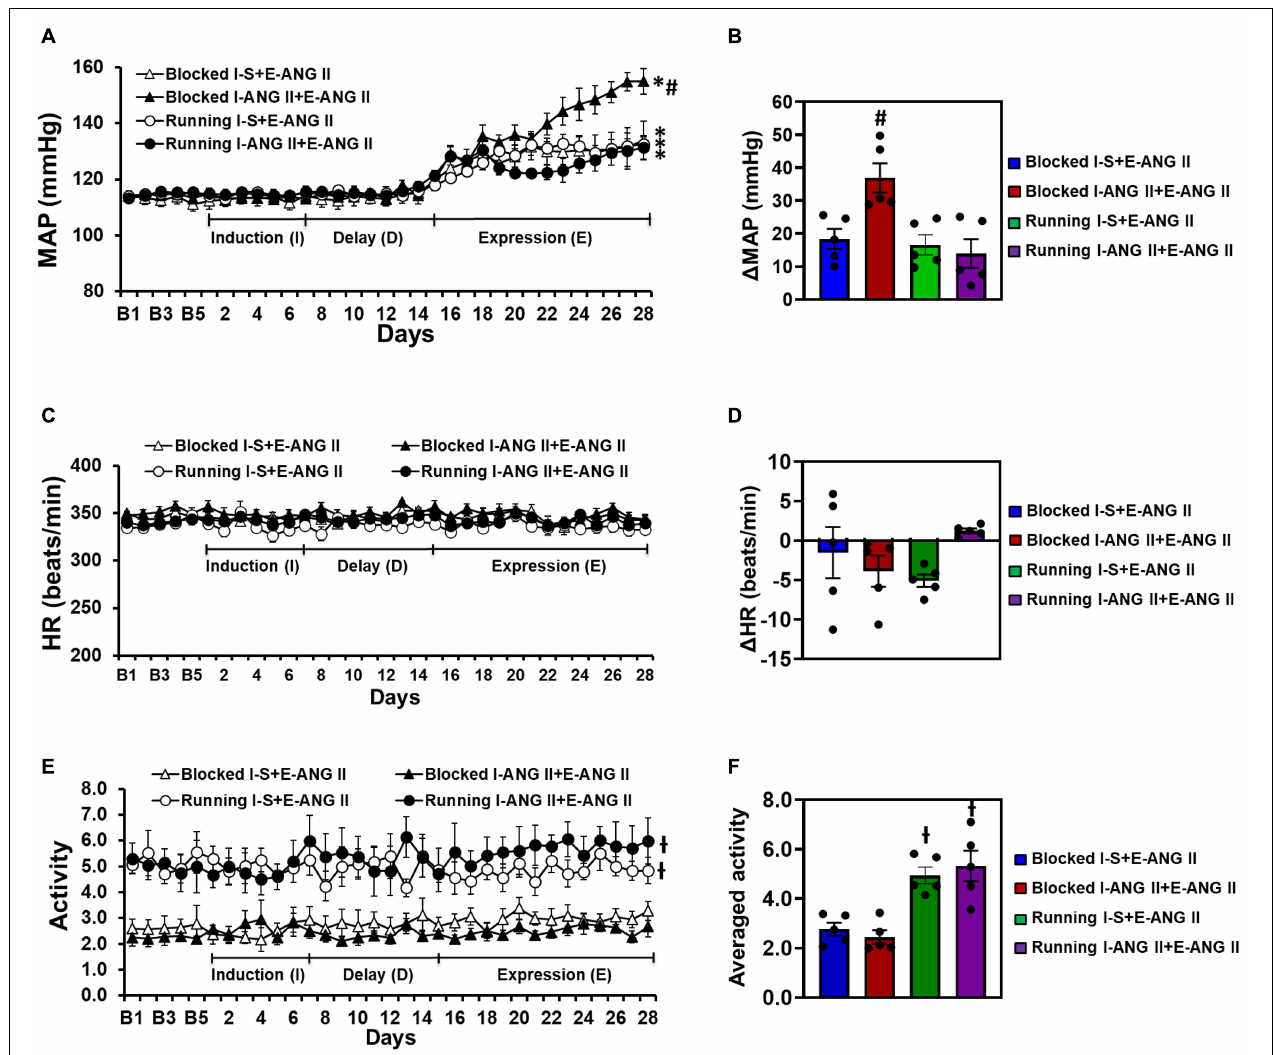
FIGURE 4 | Voluntary exercise prevented hypertensive response sensitization to angiotensin (ANG) II treatment although the locomotor activities of the rats were elevated. HRs were comparable in all groups of offspring. Daily and averaged mean arterial pressure (MAP, A,B ), heart rate (HR, C,D ) and locomotor activity (E,F) in sedentary (Blocked) or exercise (Running) rats during the Induction-Delay-Expression (I-D-E) paradigm. ( n = 5/group; two-way ANOVA was used for analysis followed by Tukey’s post-hoc tests. p < 0.05, * vs. baseline; # vs. blocked I-S + E-ANG II and running rats; -I vs. blocked